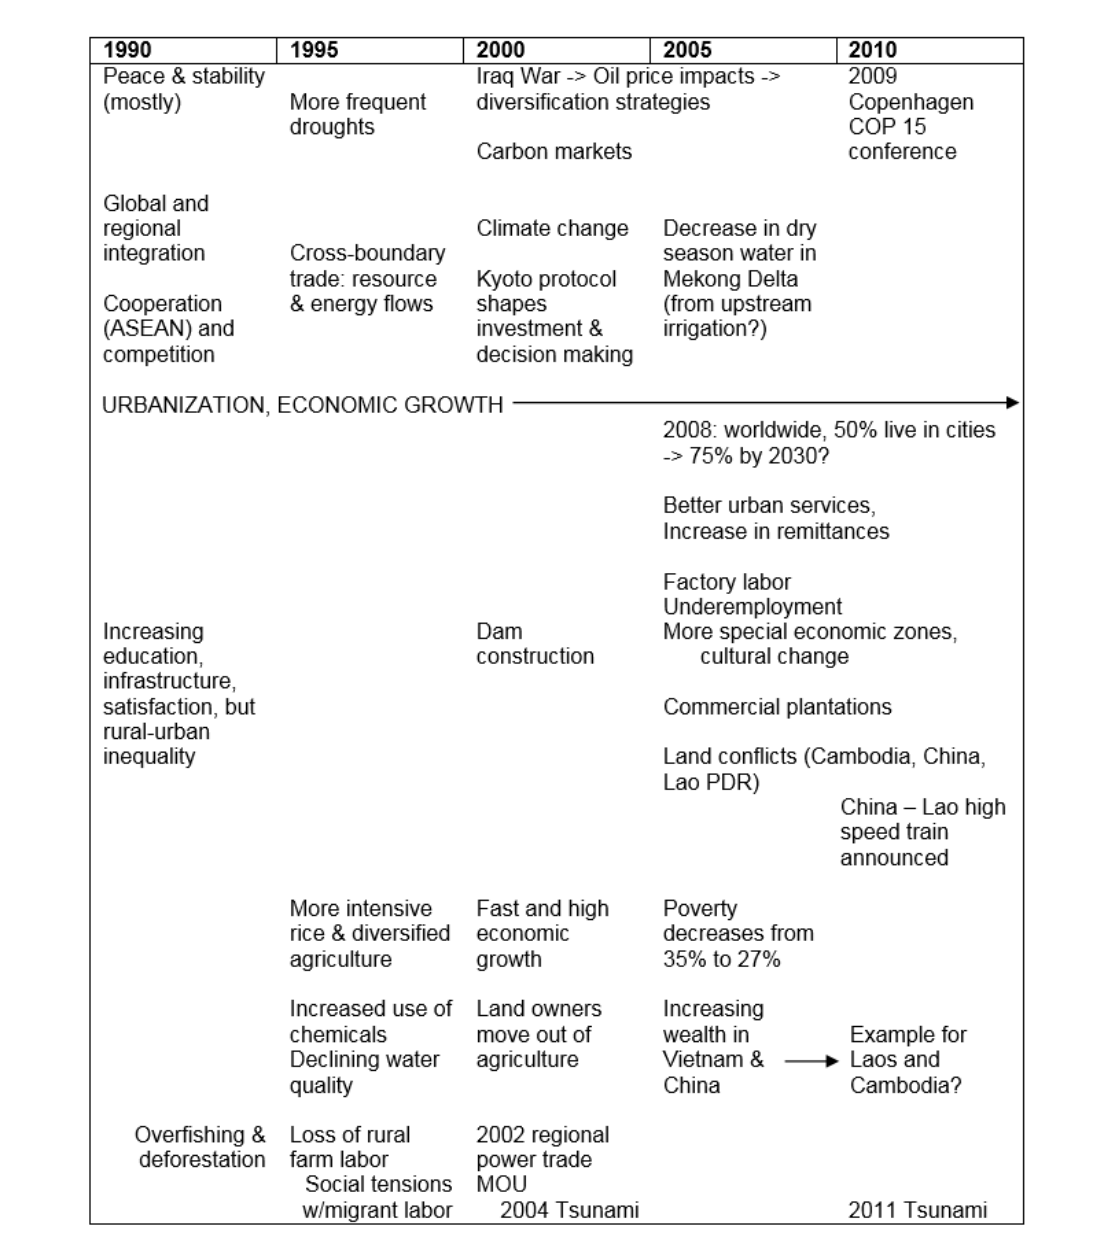
Fig. 3 . Example of historical review. Source: After Regional Group 3 in Foran et al.